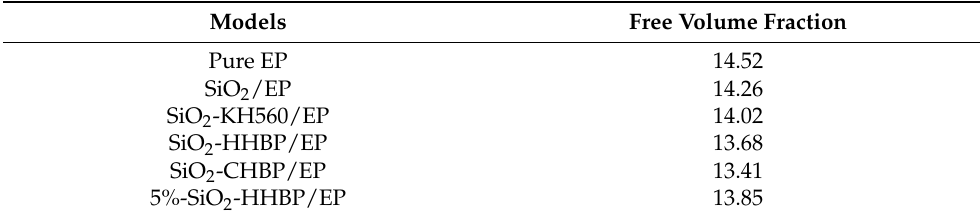
Table 5. The free volume fractions of models (units: 100%).